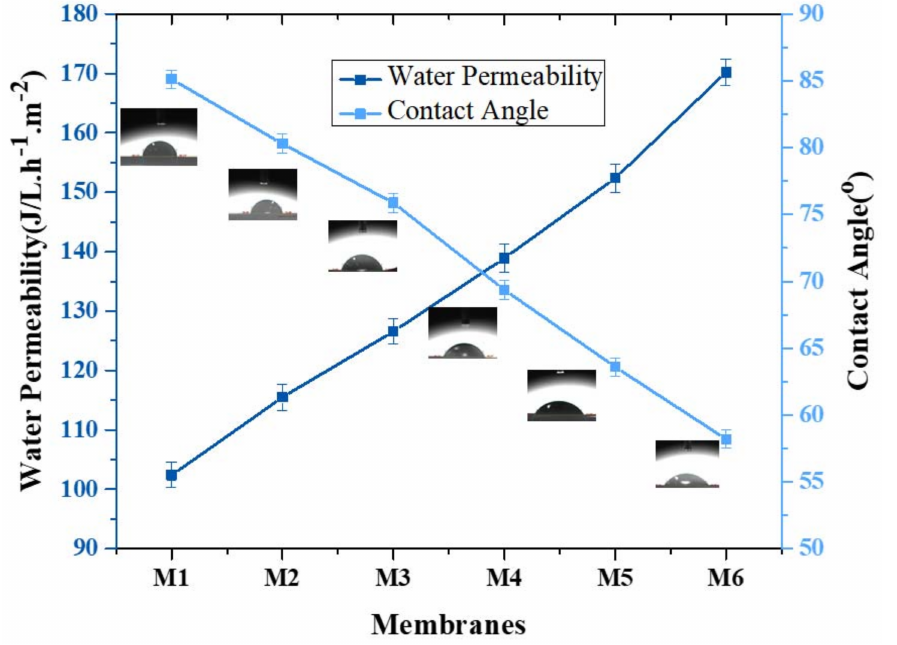
Figure 10. Trend of water permeability vs. contact angle of aminated graphene oxide–based PVDF membranes. Table 2. Water permeability, BSA rejection and dyes removal of AGO based PVDF